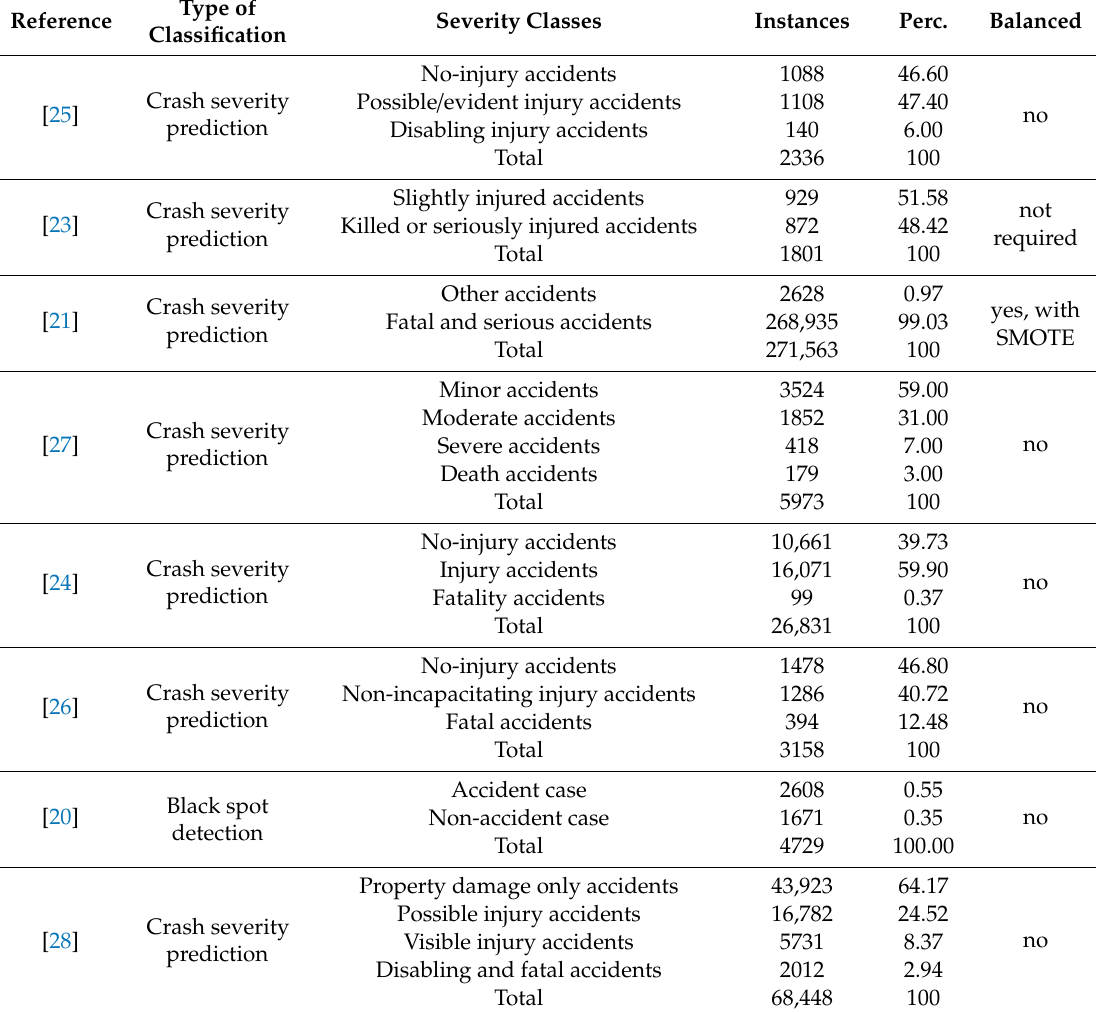
Table 1. Dataset used for predicting crash severity or detecting black spots by